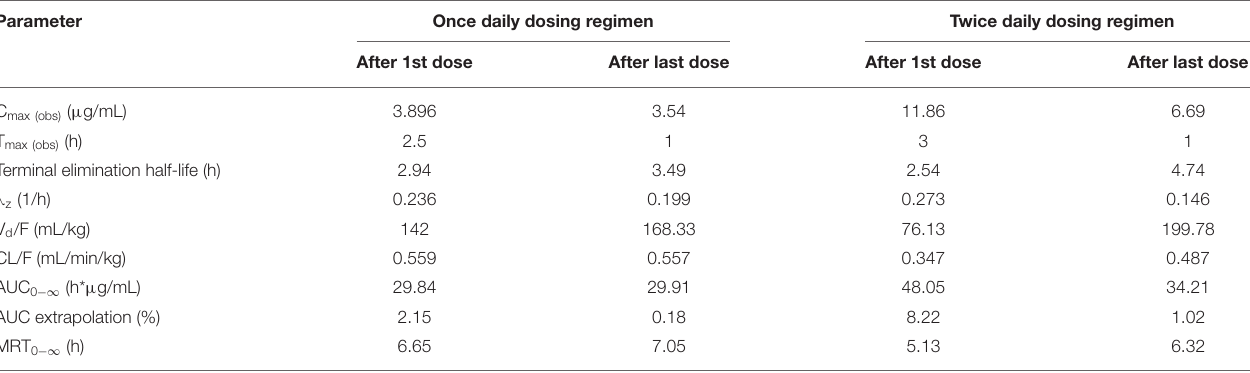
TABLE 3 | Pharmacokinetic parameters estimated from meloxicam concentrations in plasma samples collected from live birds (pre-slaughter) and at slaughter following two oral meloxicam dosing regimens (1 mg/kg once daily for 8 doses or 1 mg/kg twice daily for 20 doses) administered to laying hens. Parameter